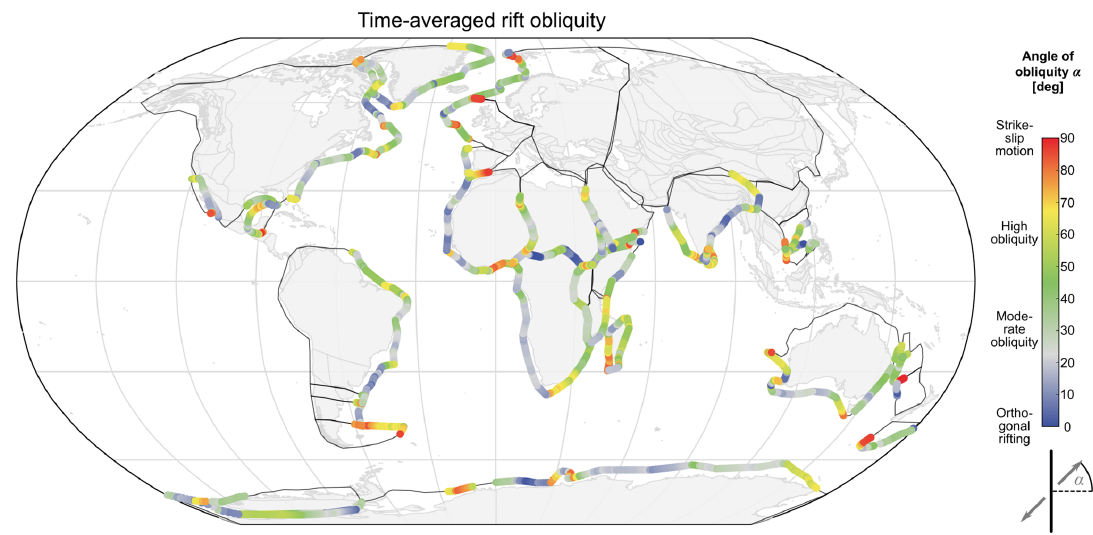
Figure 9. Global map of mean rift obliquity. For each rift point we display the time-averaged rift obliquity illustrating the prevalence of oblique rifting since Pangea fragmentation. Note that temporal changes in rift obliquity cannot be visualized in this